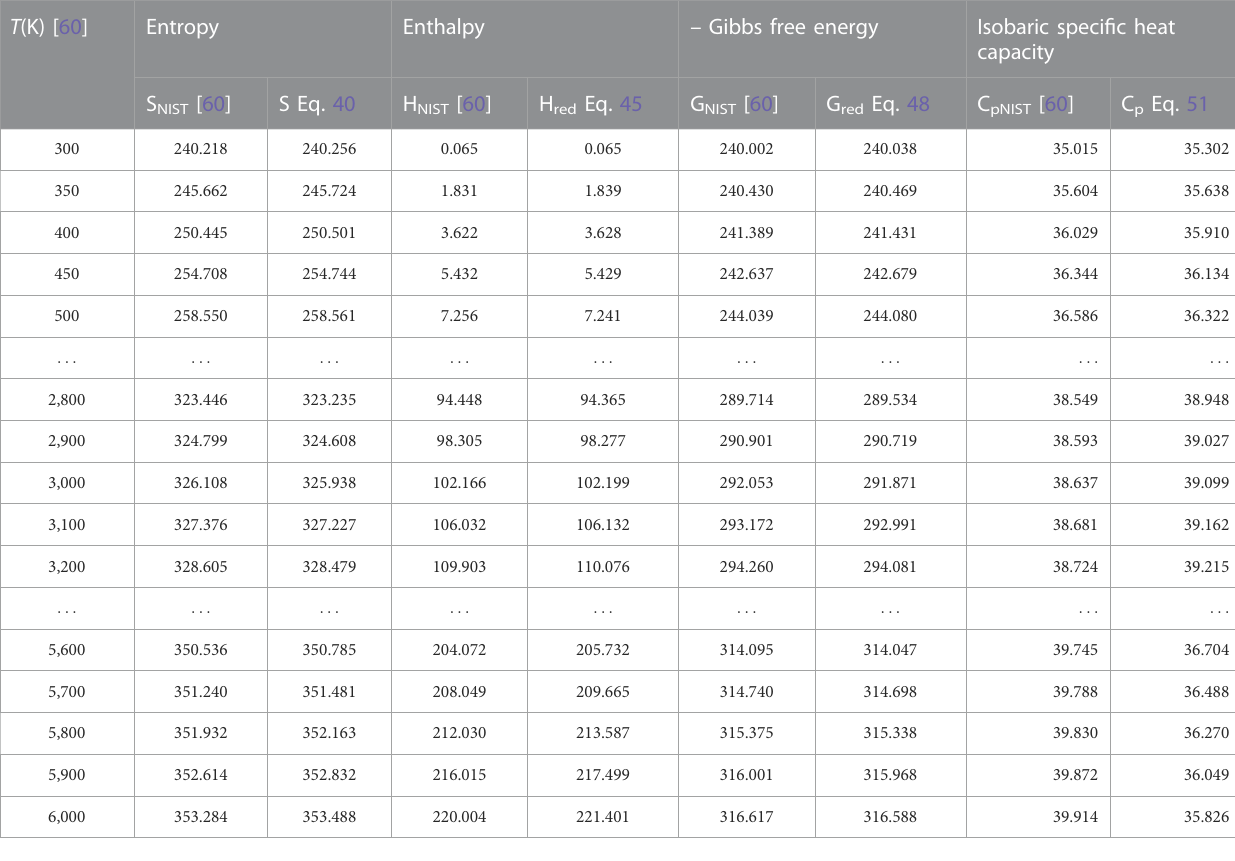
TABLE 6 Computed data on molar entropy (J mol − 1 K − 1 ), reduced enthalpy (kJ mol − 1 ), reduced Gibbs free energy, and isobaric speci fi c heat capacity for the BrCl (X 1 Σ + ) molecule. N p =